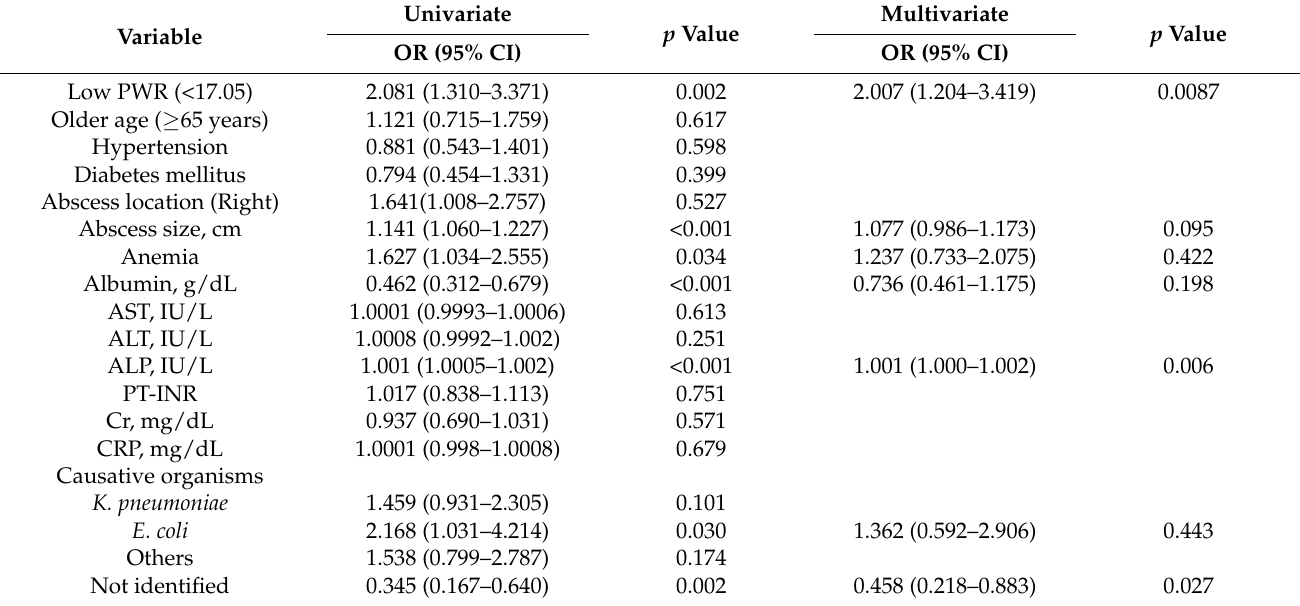
Table 4. Risk factors for pleural effusion in patients with pyogenic liver